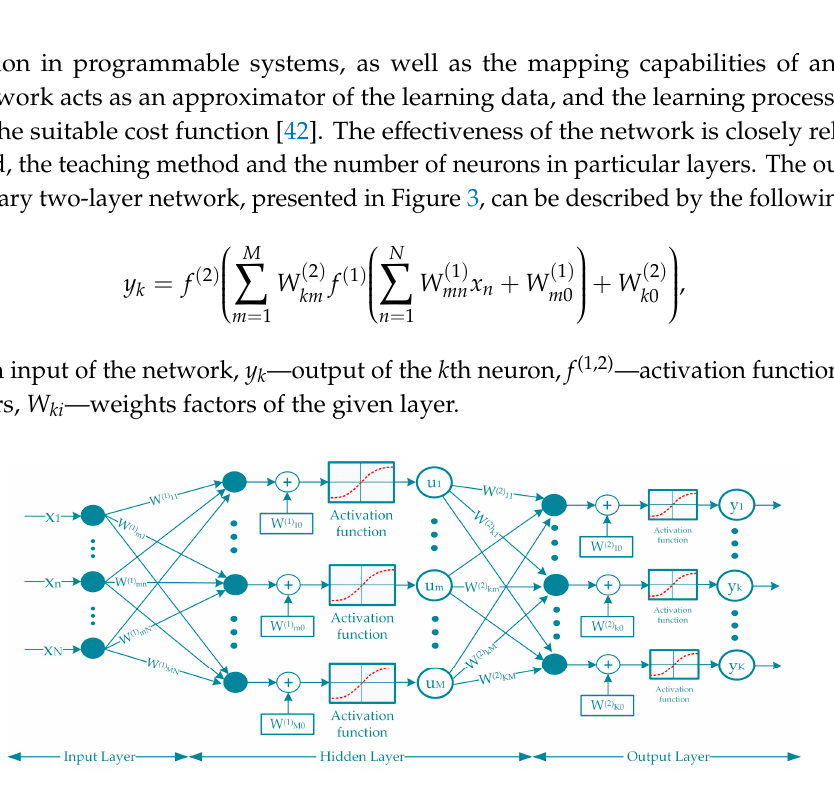
Figure 3. Structure of the feedforward MLP network (two-layer in this example).